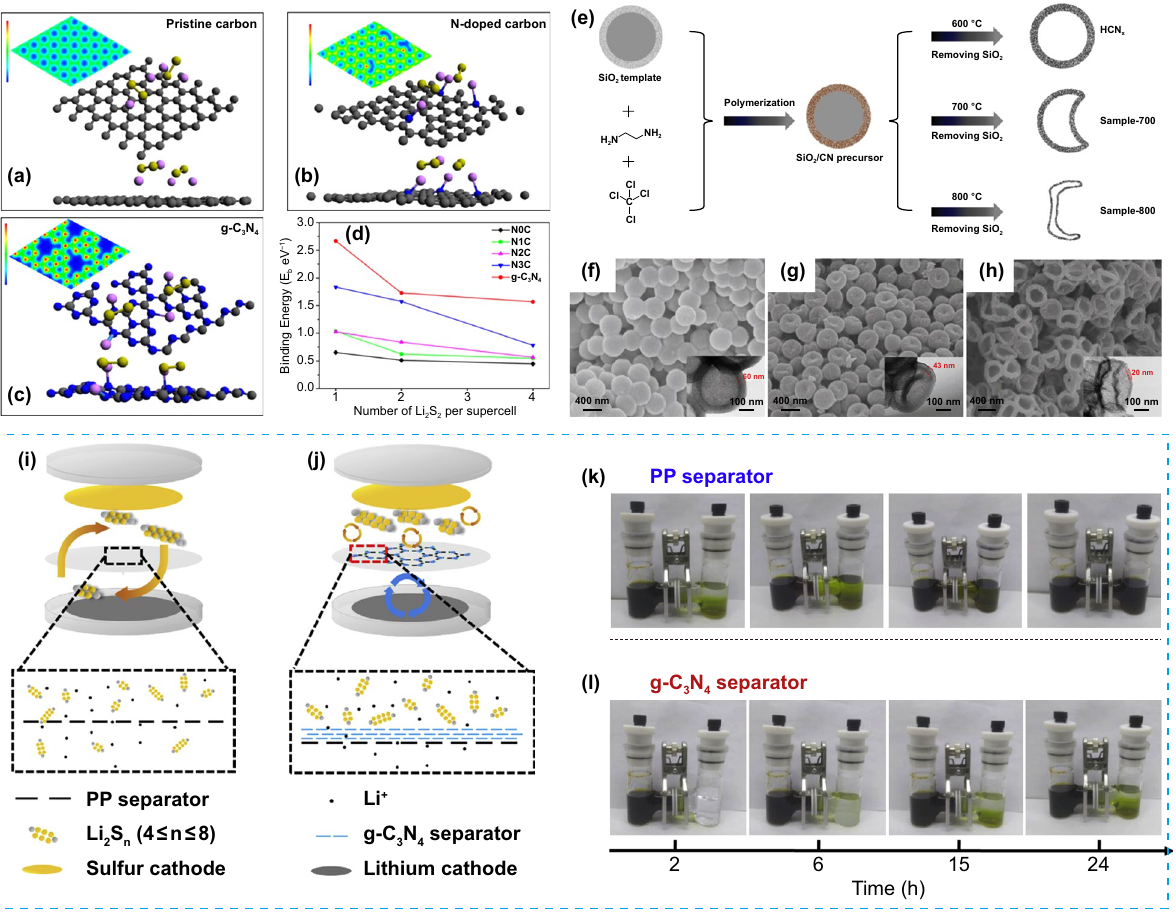
Fig. 3 The most stable adsorption models of two Li 2 S 2 molecules on a pristine carbon, b N‑doped carbon, and c g‑C 3 N 4 ; the insets in the top left show the two‑dimensional deformation charge distributions of the corresponding matrixes without Li 2 S 2 (red for receiving electron and blue for giving electron). d The binding energies (per Li 2 S 2 ) of Li 2 S 2 molecules on different matrixes as the number of Li 2 S 2 changes [35]. Copyright 2016, American Chemical Society. e Schematic illustration of the preparation process of HCN x , sample‑700 and sample‑800. f SEM and TEM images of HCN x , g sample‑700 and h sample‑800 [45]. Copyright 2017, Wiley–VCH. Schematic illustration of Li–S cells with i PP separator and j